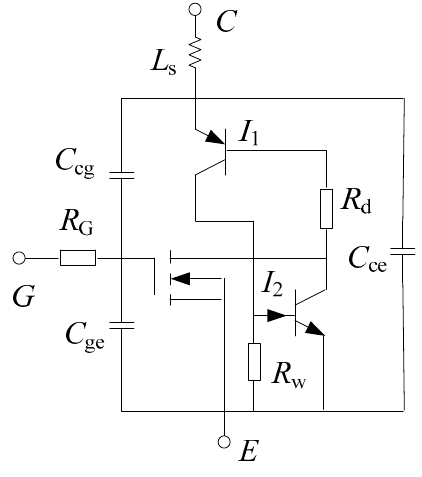
Figure 1. Equivalent circuit of IGBT.